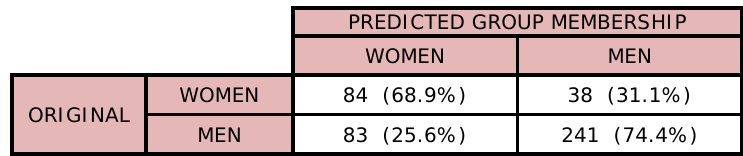
Table 3. “Classification of the subjects by discriminant analysis”. Source: authors